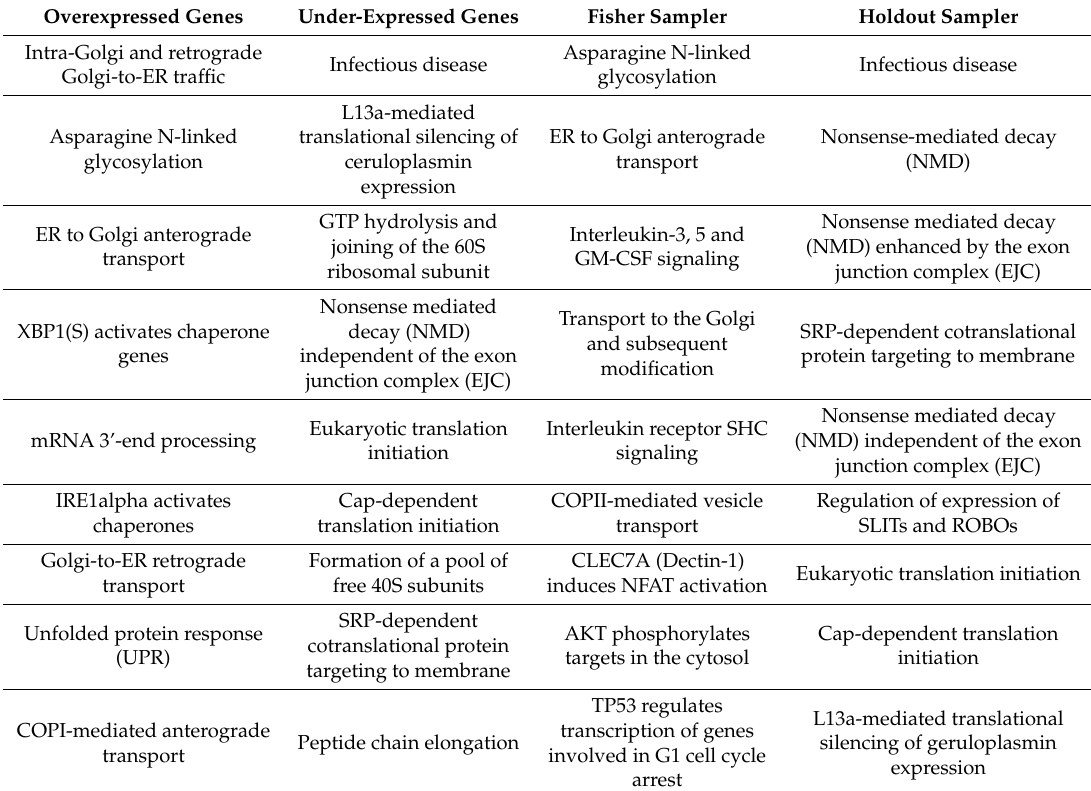
GSE6477. Hyperdiploid differentiation. Pathway analysis via the Fisher’s ratio and holdout